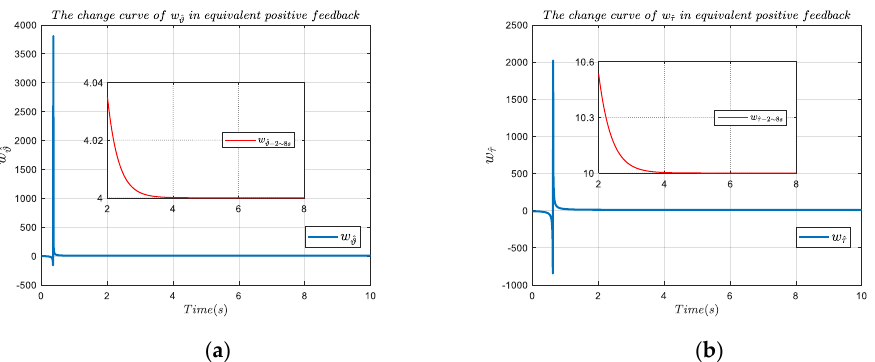
Figure 6. ( a ) Parameter change of 𝑤 𝜗̂ within 10 s and 2–8 s of equivalent positive feedback; ( b ) parameter change of 𝑤 𝜏̂ within 10 s and 2–8 s of equivalent positive feedback.